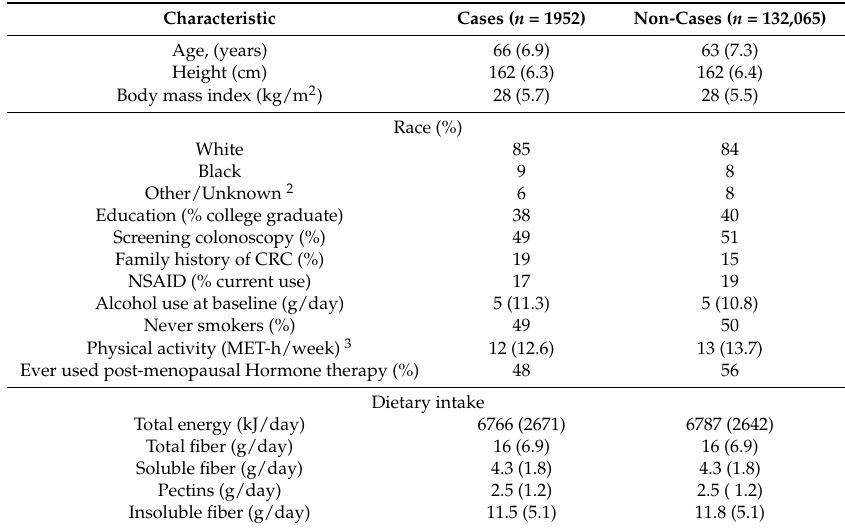
Table 1. Baseline characteristics, colorectal cancer risk factors, and dietary constituents for participants in the Women’s Health Initiative 1993–2010 1